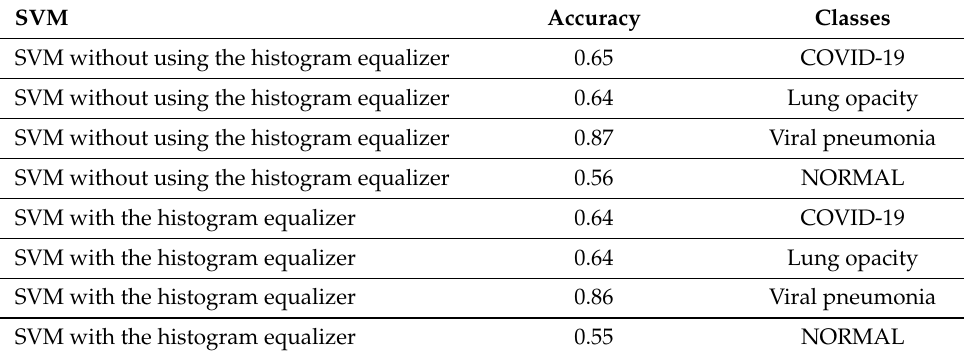
Figure 9. Comparing the accuracy of different correlation of the four lung diseases using CLAHE and SURF features with SVM learning. Table 1. Summary of the baseline accuracy: SURF features and SVM.